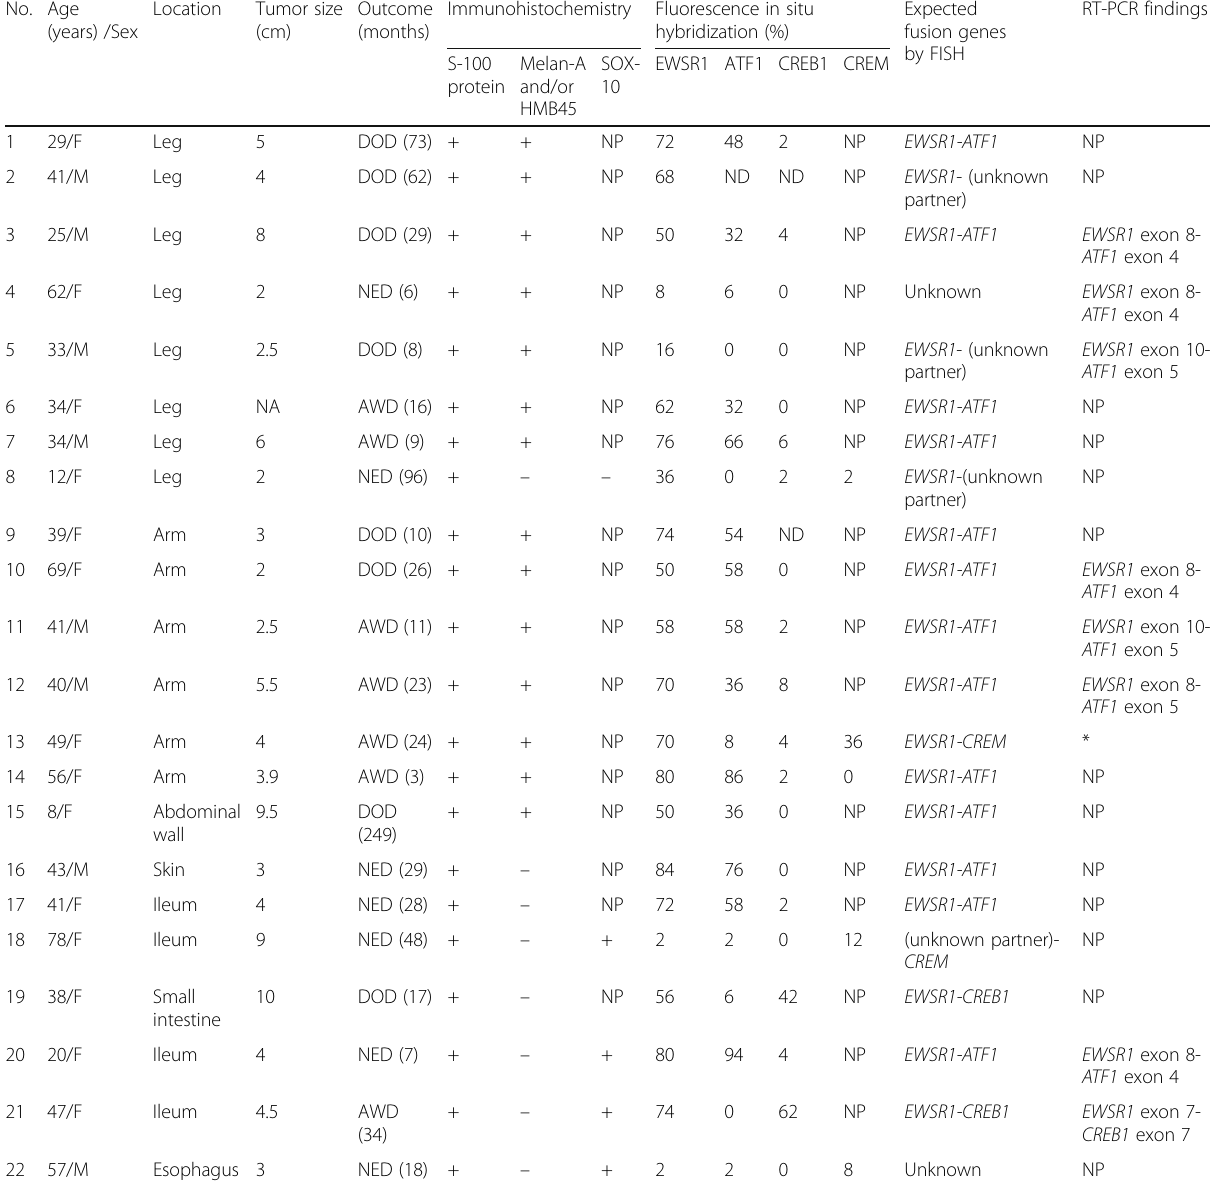
Table 1 Summary of clinical, immunohistochemical, and genetic findings of CCSST and CCSLGT cases No. Age (years) /Sex